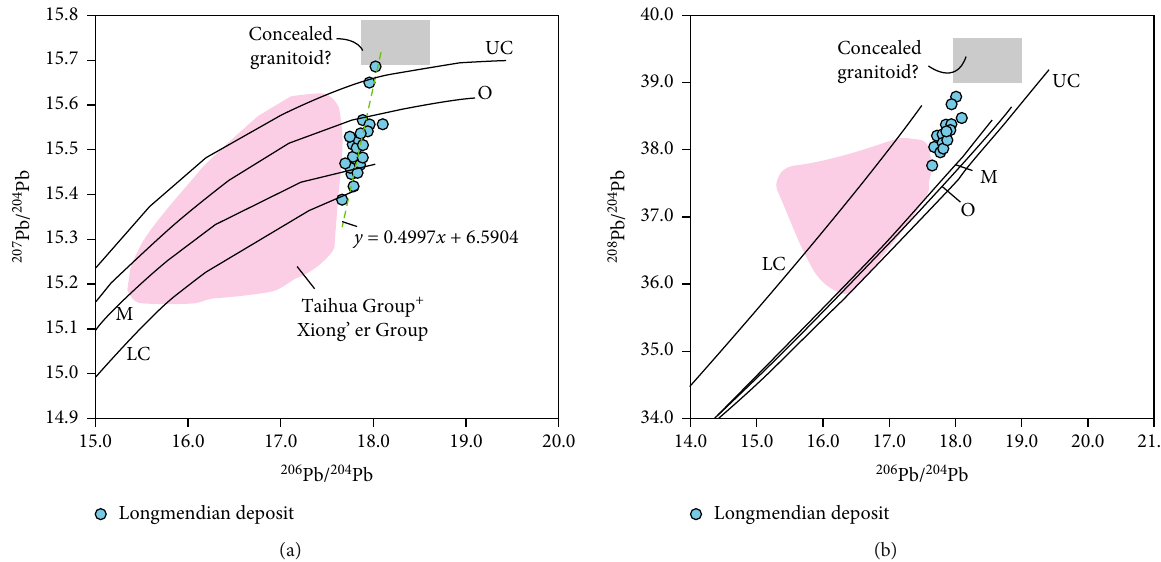
Figure 12: Sul fi de Pb isotope compositions of the Longmendian deposit. Compositional fi elds for the upper crust (UC), orogens (O), mantle (M), and lower crust (LC) are from Zartman and Doe